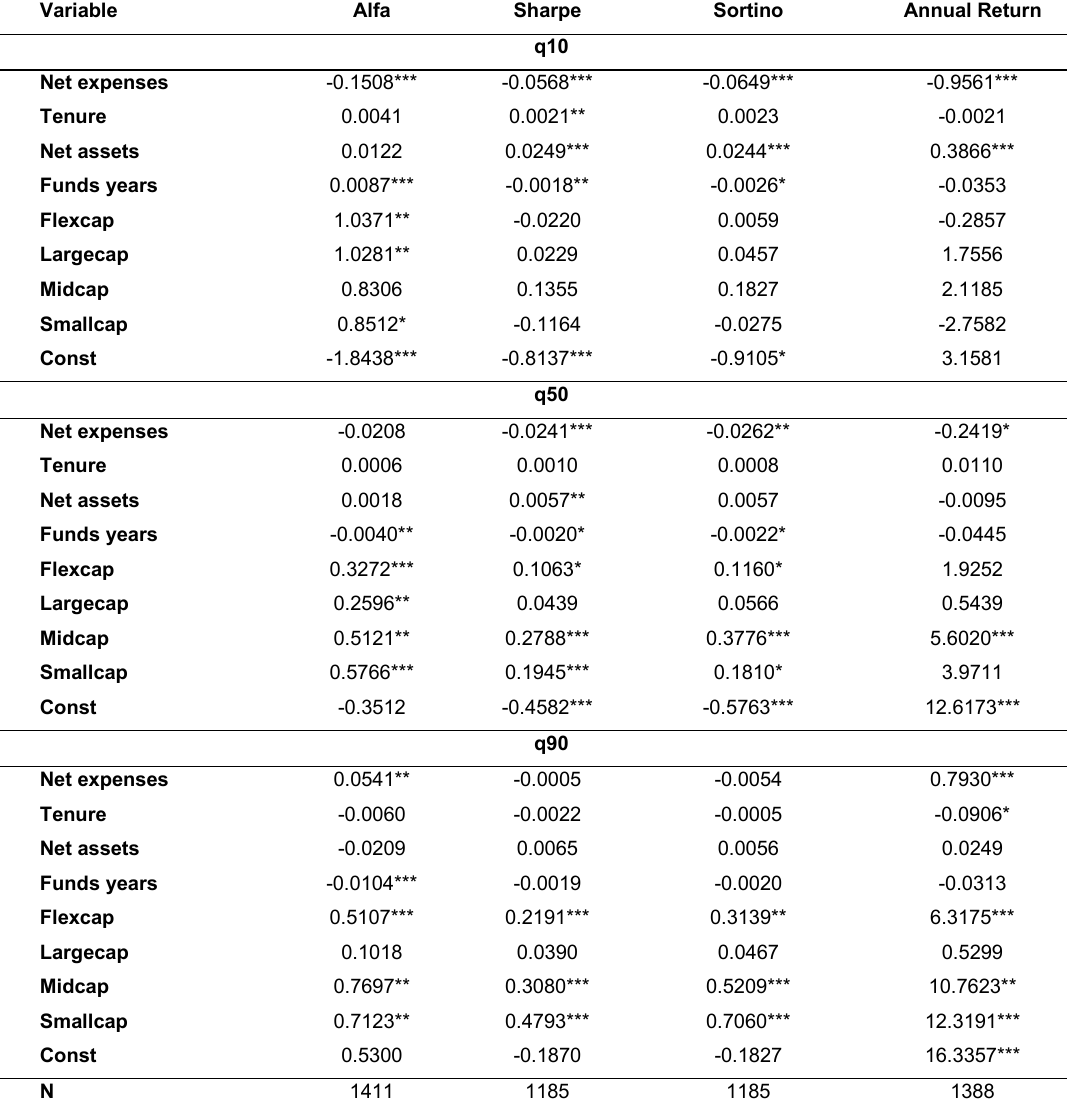
Table 6. Quantile regression of the relationship between performance and